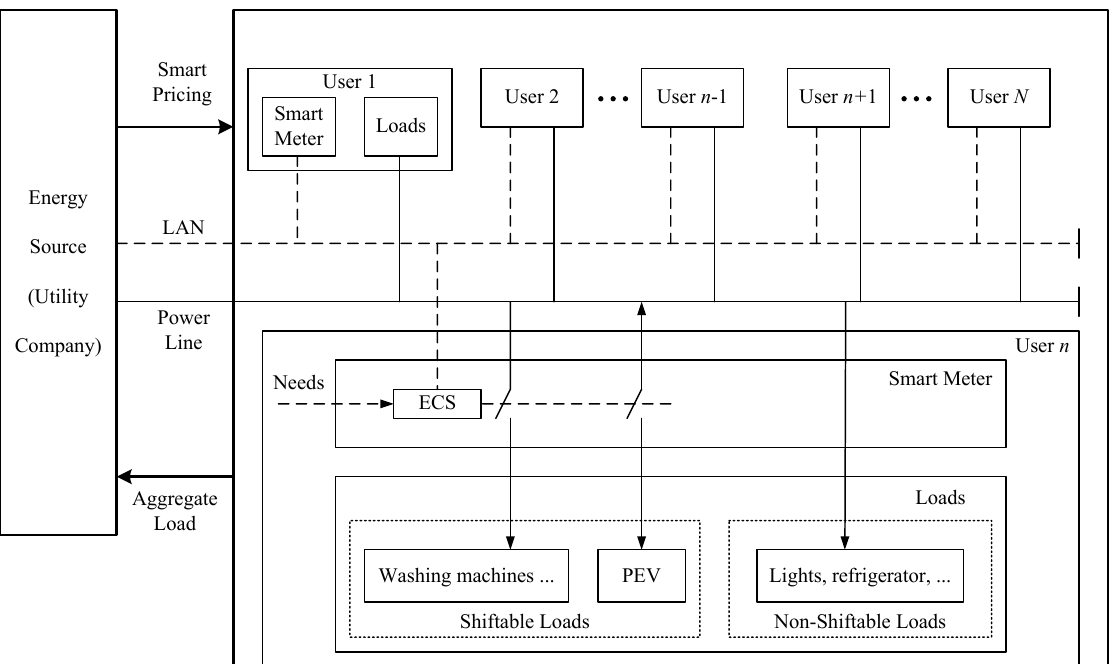
Figure 1. A demand side management strategy for the smart grid with interactions among the utility company and the users via smart meters with energy consumption scheduling capability. ECS: energy consumption scheduling; PEV: plug-in electric